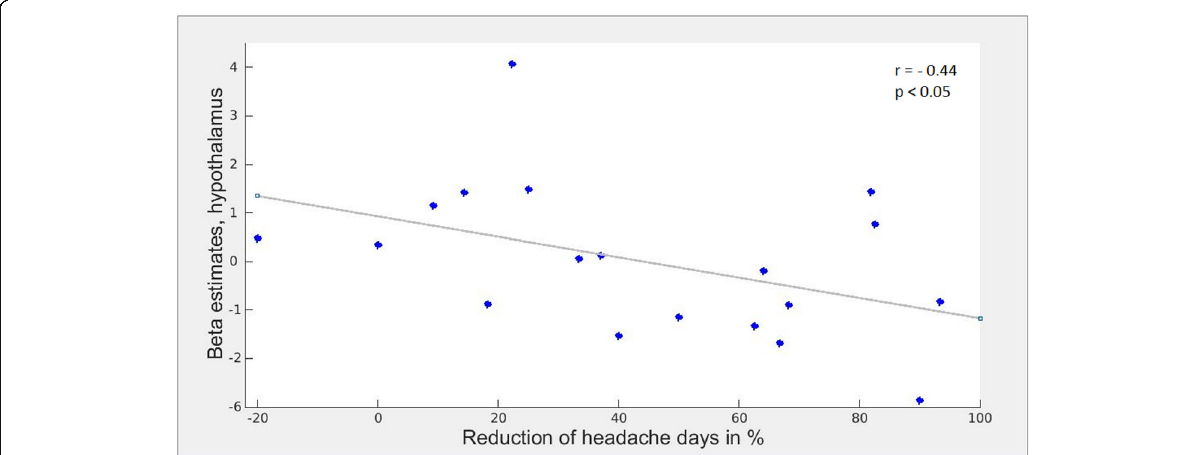
Fig. 5 Relationship of hypothalamic activity and the reduction of headache days in patients under metoprolol treatment. A bigger reduction of headache days in patients, marked by a higher percentage of reduction, is related to lower beta estimates within a cluster in the left hypothalamus (peak: x = − 8, y = − 8, z = −